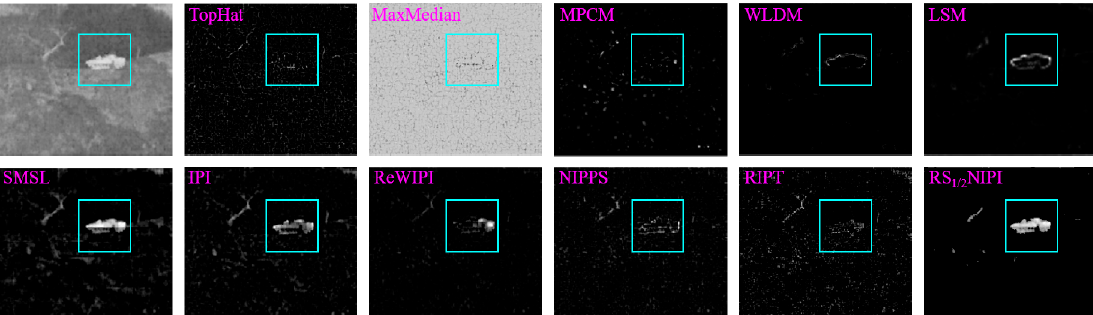
Figure 14. An example of structurally sparse target scenes and the corresponding detection results obtained by the proposed method compared with ten competitive methods.